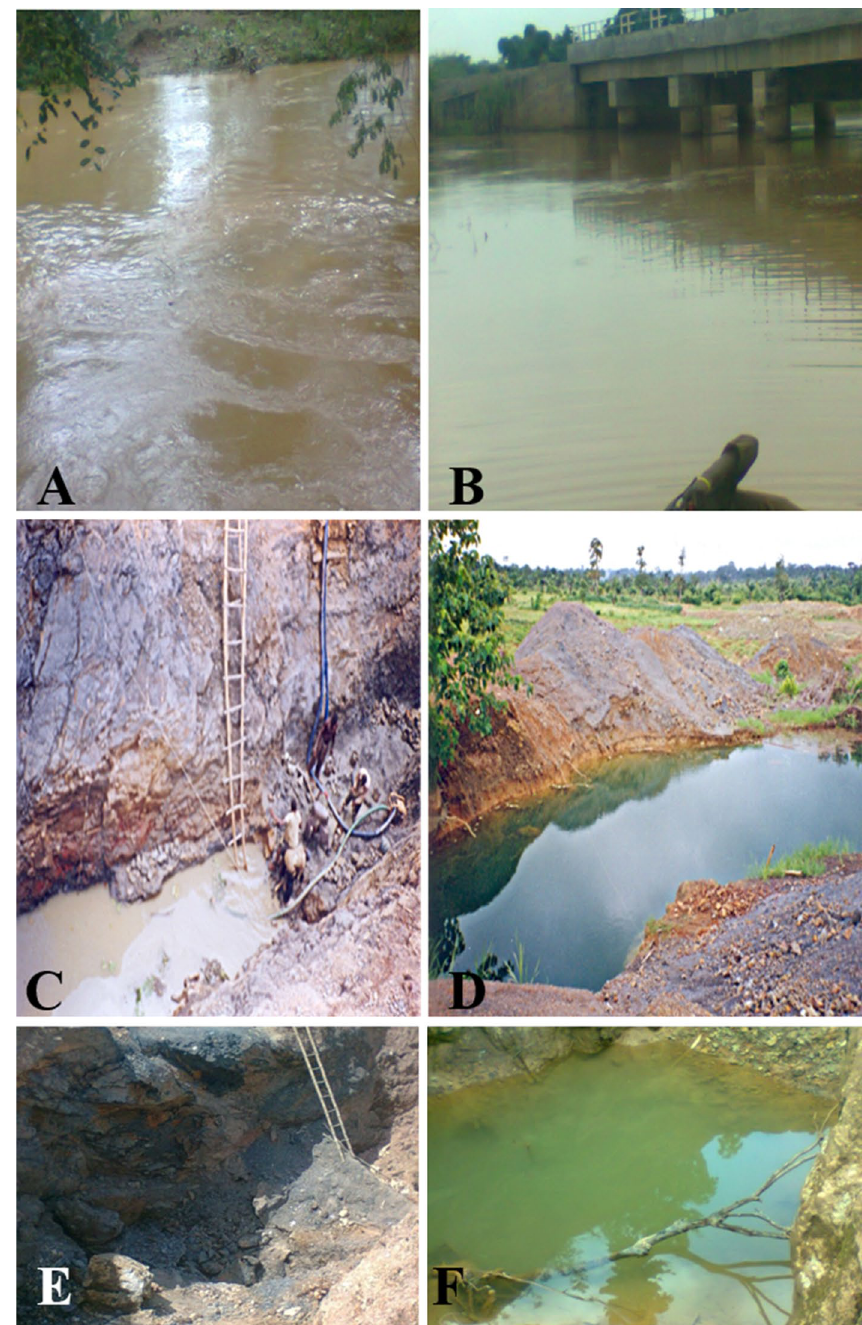
Fig. 2 ‑ Water sources: a Akpara Izzi stream, one of the tributaries of Ebonyi River b sampled for this study. Ebonyi River is the major source of water for farming and domes- tic usages of the inhabitants of Enyigba, Ebonyi State of Nigeria. c Example of active mine pit showing the wooden ladder being used for mining operations, the blue pipe being used for draining water from the mine pit into the adjoining farmlands, Akpara Izzi stream and other streams within the vicinity of the mining sites. d and f examples of abandoned mine pits filled with water and heaps of fine-grained wastes (tailings) surrounding the